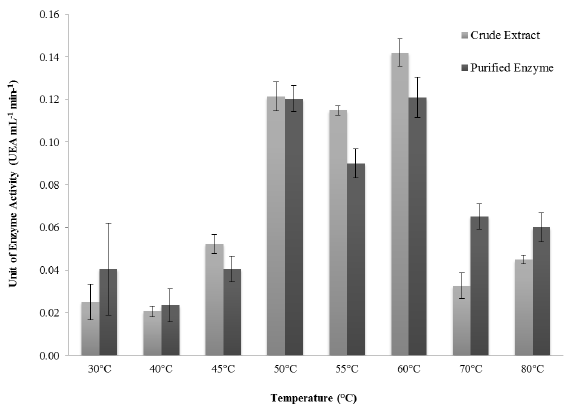
Figure 2 - Evaluation of activity and stability for CMCase crude extract face to pH range of 4.0-10.0. Assay performed after 30 minutes of incubation at 60°C.